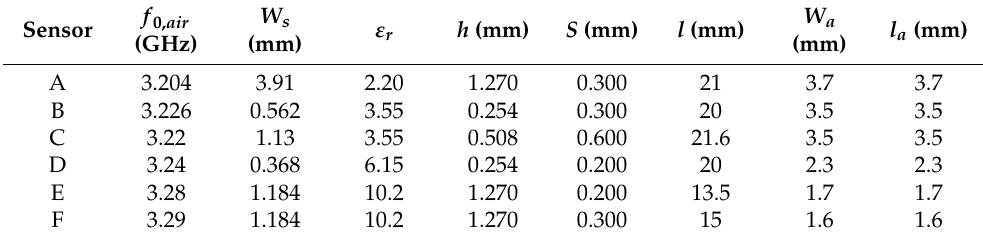
Table 1. Geometry and substrate parameters for the considered